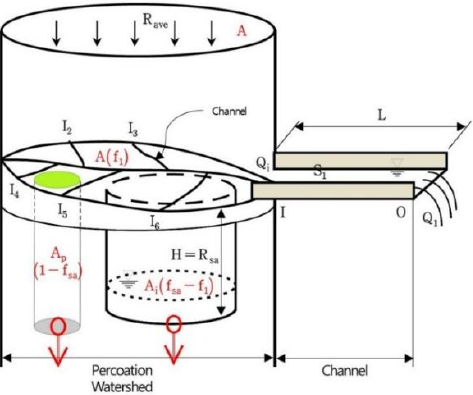
Figure 2. Schematic diagram of the storage function model [17].